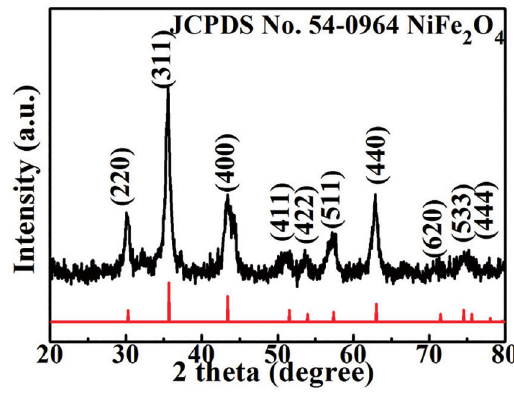
O powders and 2 4